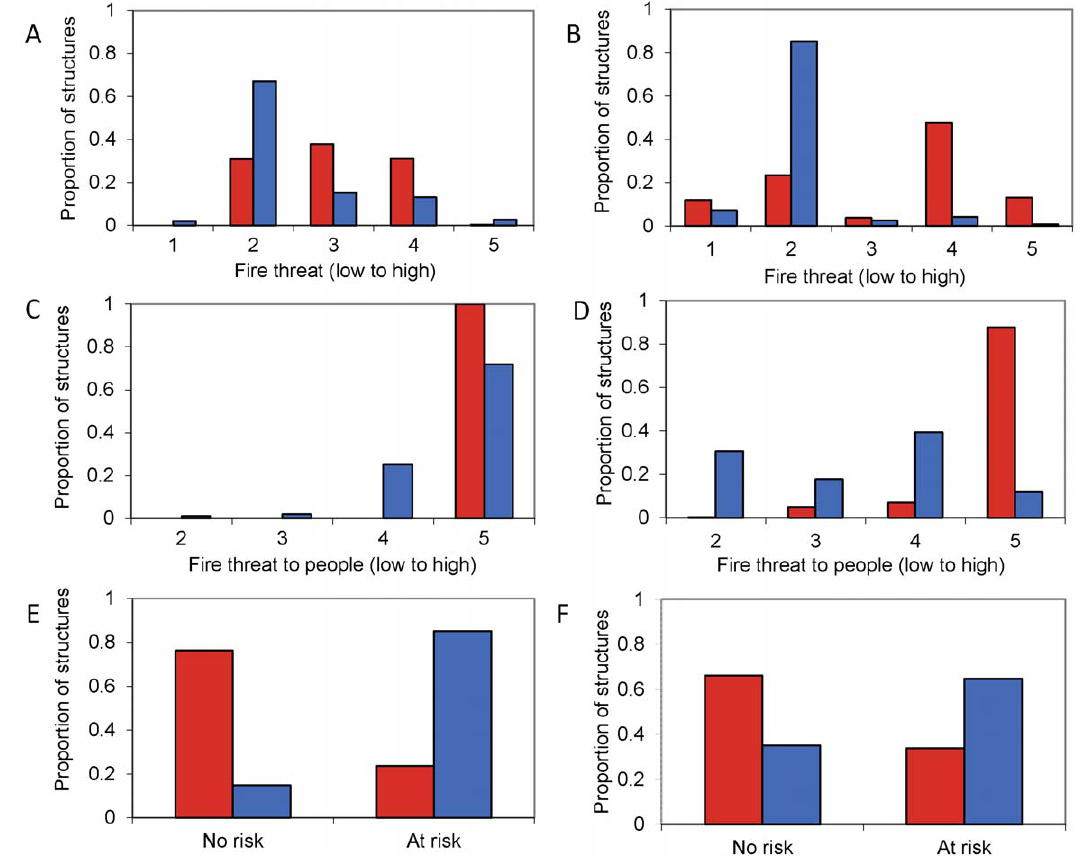
Figure 8. Distribution of actual burned structures in classes of statewide fire hazard maps. Proportion of structures burned (in red) or unaffected (in blue) distributed within map classes of: (A) CDF ‘‘Fire threat’’ in Santa Monica Mountains. (B) CDF ‘‘Fire threa’’ in San Diego County. (C) CDF ‘‘Fire threat to people’’ in Santa Monica Mountains (D) CDF ‘‘Fire threat to people’’ in San Diego County (E) CDF ‘‘Communities at risk’’ in Santa Monica Mountains (F) CDF ‘‘Communities at risk’’ in San Diego County. CDF – California Department of Forestry and Fire Protection.